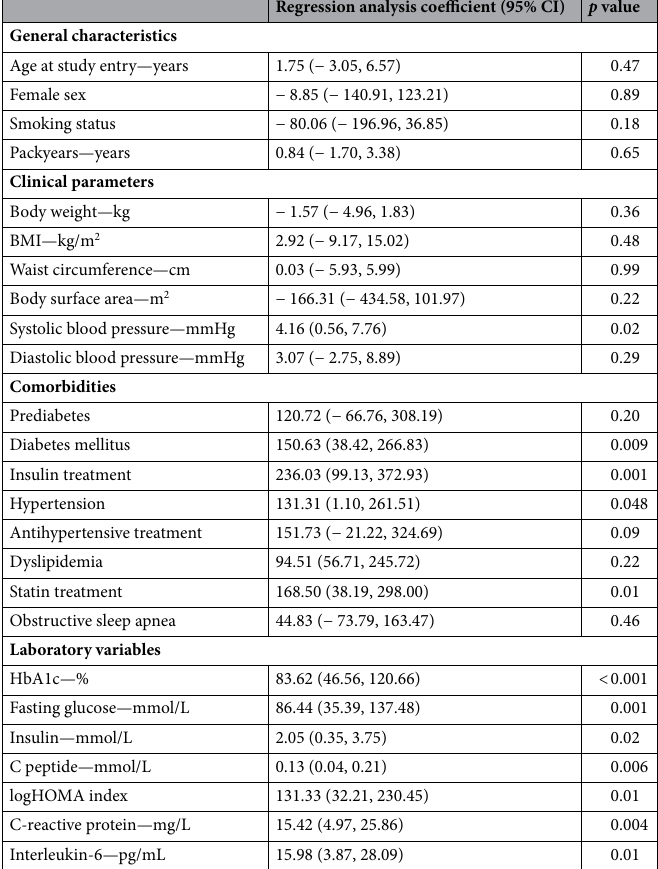
Table 2. Association of baseline FGF21 levels with demographic characteristics, comorbidities and clinical variables. All laboratory values were obtained after overnight fast. Due to skewed distribution, HOMA-index was